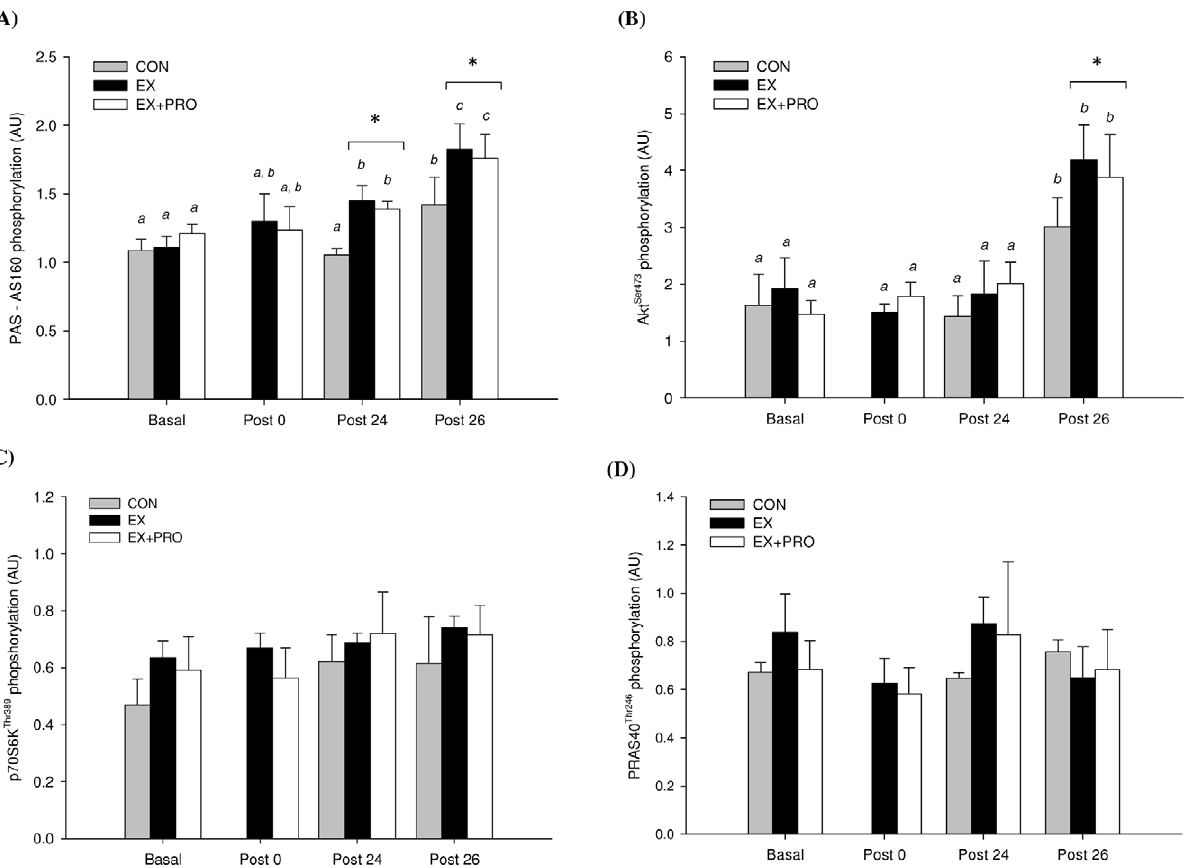
Figure 6. Signalling protein phosphorylation of (A) Akt ser473 , (B) PAS-AS160/TBC1D4, (C) p70S6K Thr389 and (D) PRAS40 Thr246 from muscle samples taken at 4 different time points. Groups as per Table 1. Values are means 6 SEM; n =6 per group. Means with different letters are significantly different from each other ( P , 0.05). *: significantly lower phosphorylation for CON compared with EX and EX + PRO ( P , 0.05). doi:10.1371/journal.pone.0020613.g006 PLoS ONE |